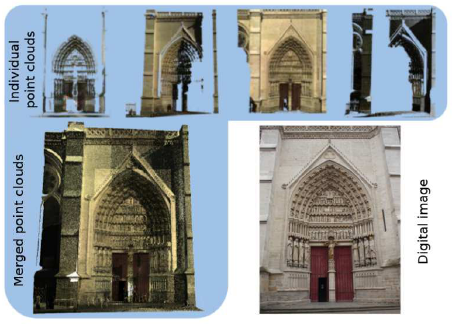
Figure 2: Color problems resulting of the point clouds merging and the scanner camera low